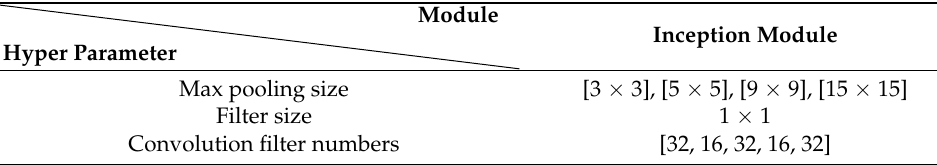
Table 3. Inception module